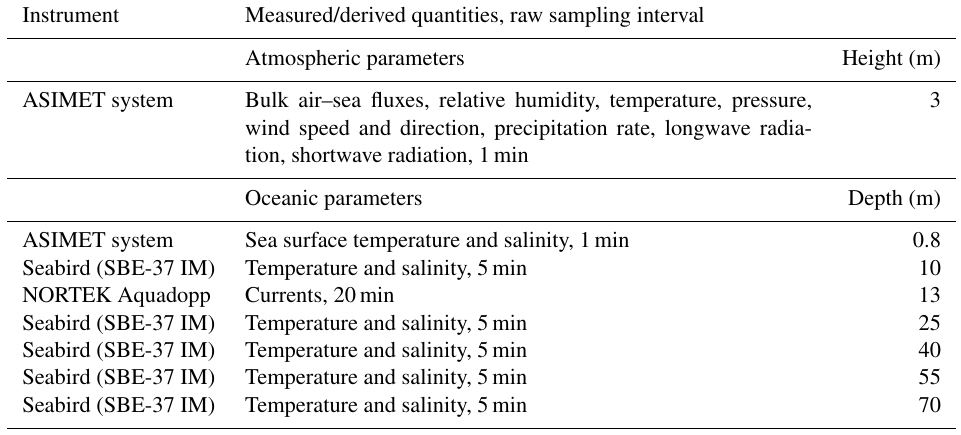
Table 4. Instrumentation providing real-time data on board the NTAS mooring. Instrument Measured/derived quantities, raw sampling